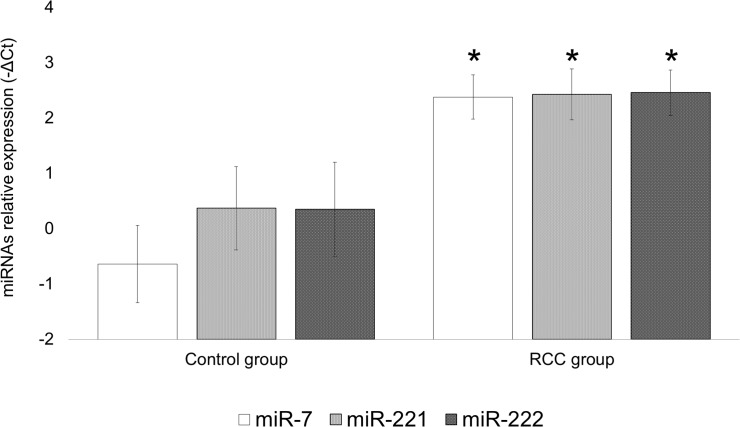
Plasma expression of miR-7, miR-221 and miR-222 in controls and RCC patients.Bars indicate mean± standard error of mean. *, P<0.050.